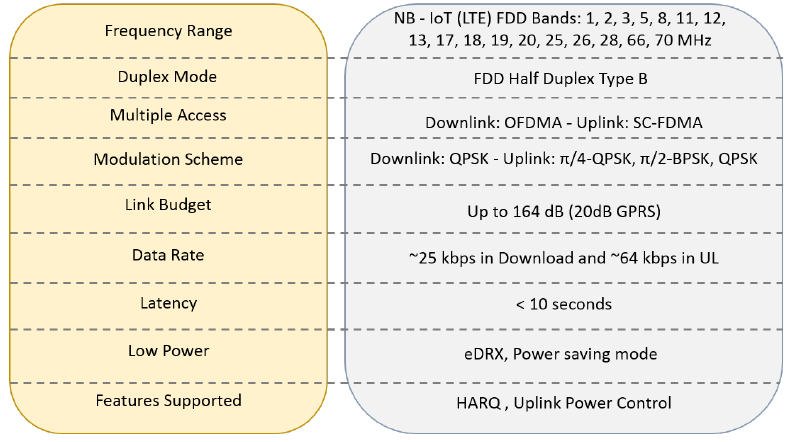
Figure 19. NB-IoT key